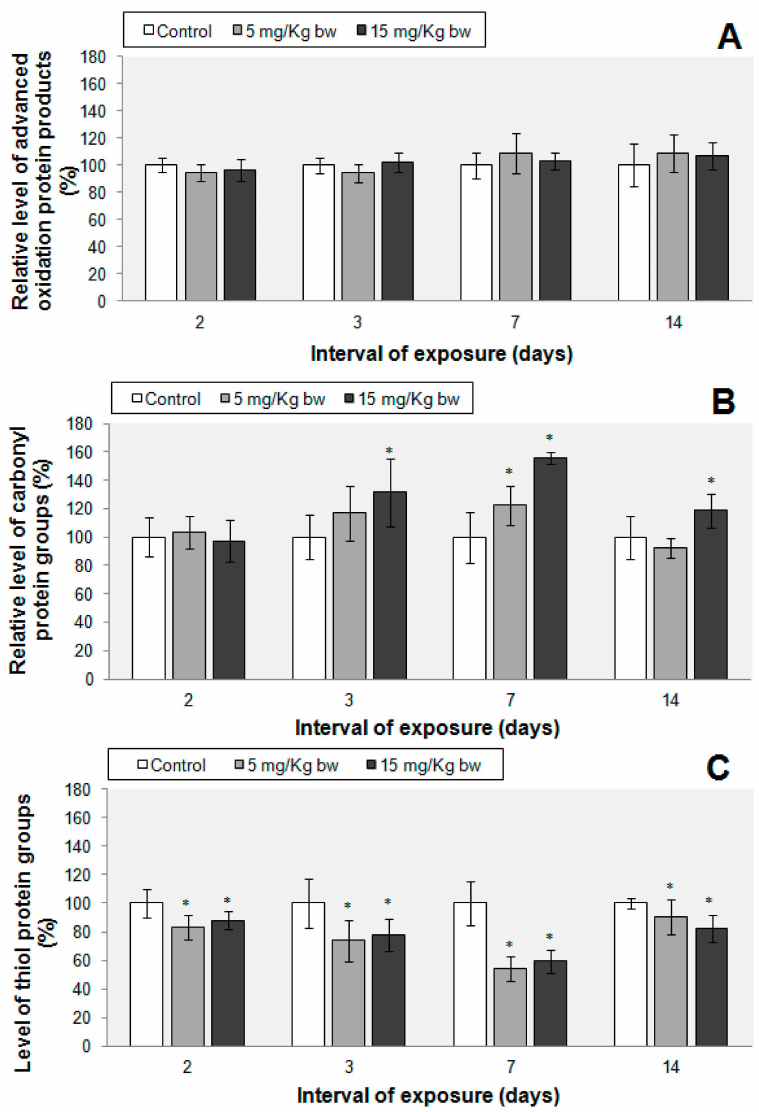
Figure 7. ( A ) Advanced oxidation protein products; ( B ) Protein carbonyl; ( C ) Protein thiol groups levels in murine lung tissue after exposure to phospholipid micelles IONPs. Data represent the relative mean ˘ standard deviation of seven animals per group. The values are expressed in percentages